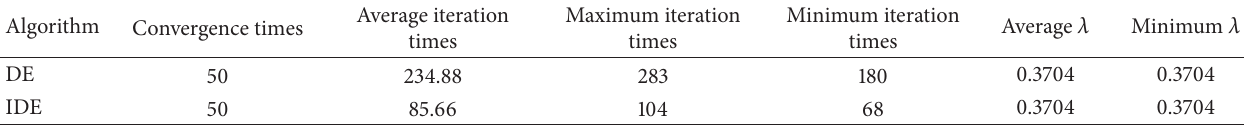
Table 3: Comparison of DE and IDE.